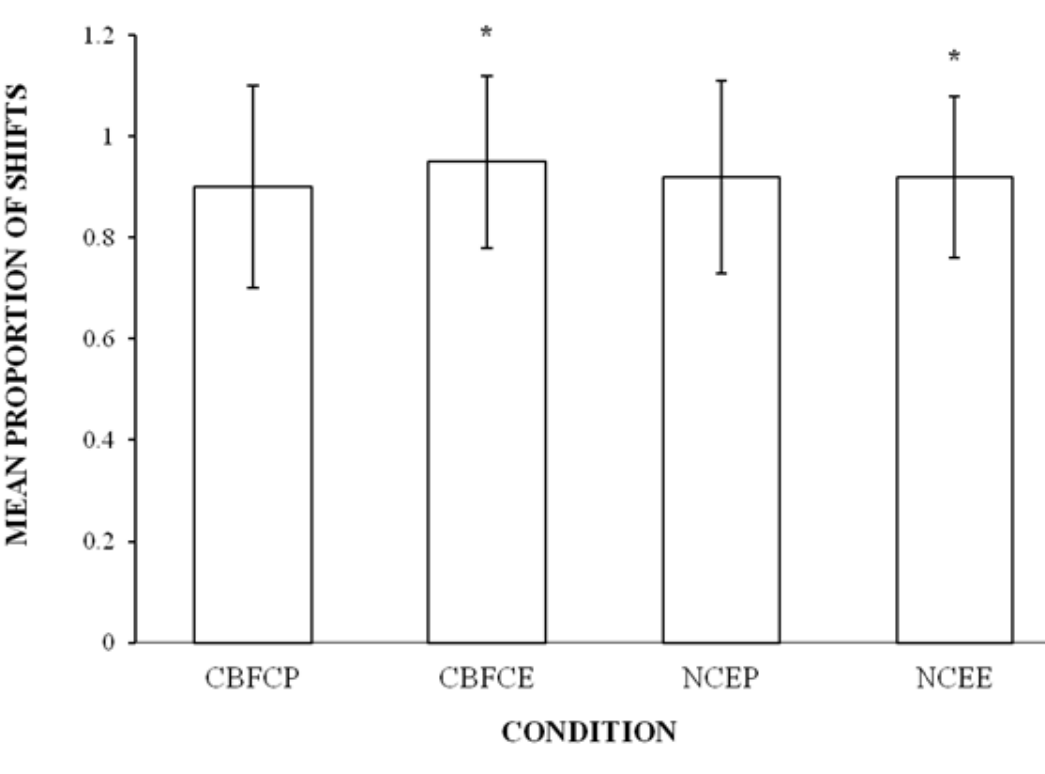
Figure 1 . The mean proportion of shifts in each condition in Stage 1.